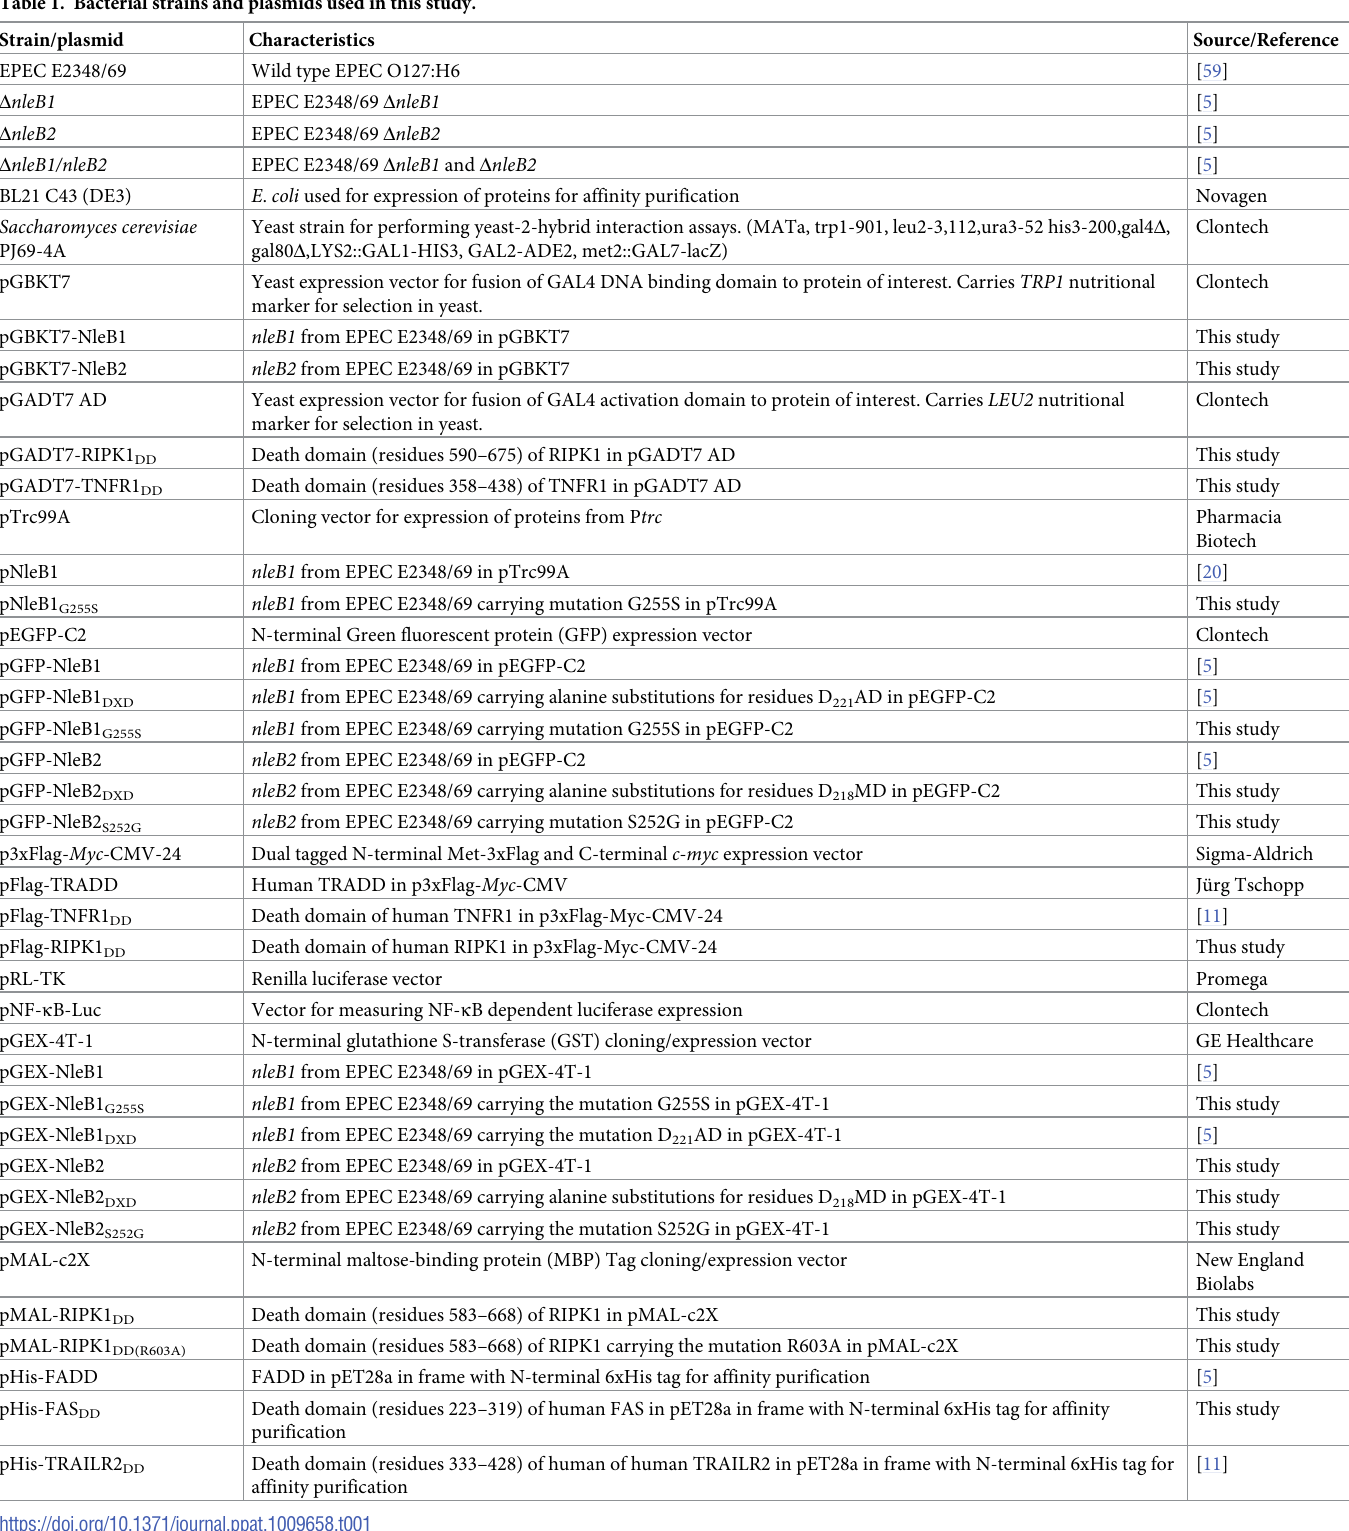
Table 1. Bacterial strains and plasmids used in this study.